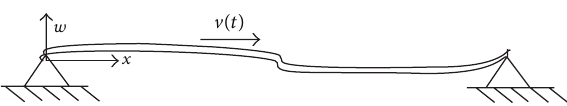
Figure 1: Schematic diagram of an axially traveling simply sup- ported beam with variable